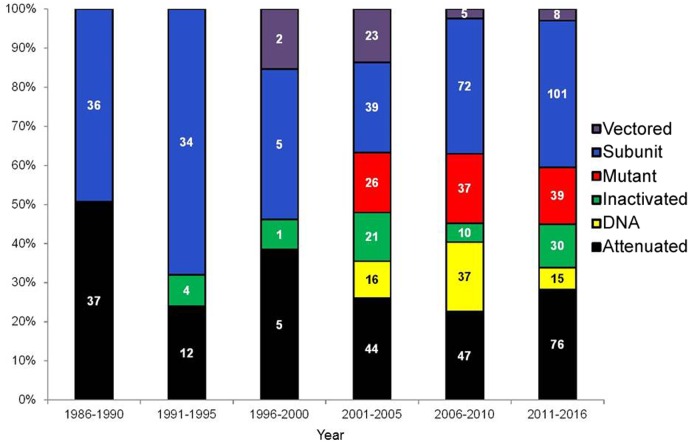
Time line with the number and percentage of experiments for brucellosis vaccine development according to the type of vaccine.Time intervals and corresponding number of experiments were: 1986–1990 (n = 73), 1991–1995 (n = 50), 1996–2000 (n = 13), 2001–2005 (n = 169), 2006–2010 (n = 208) e 2011–2016 (n = 269). The number of experiments for each data point is indicated in the graph.